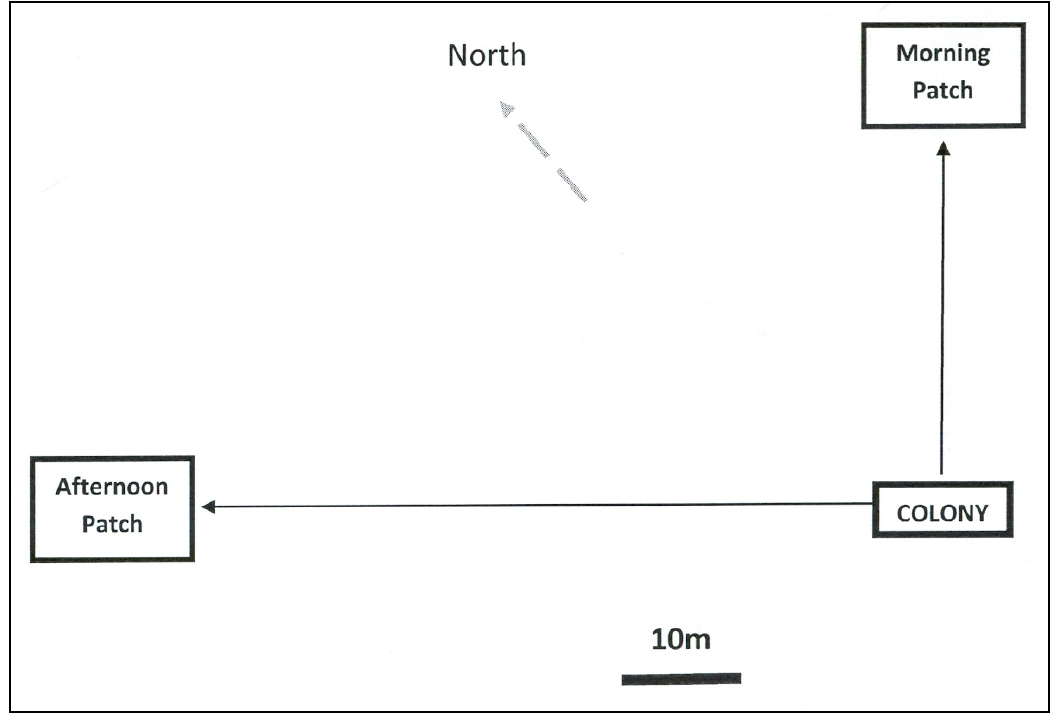
Figure 2. Scheme of geographic layout of the experiment giving the location of the honey bee colony, and experimental sites where flower patches were located (drawn by